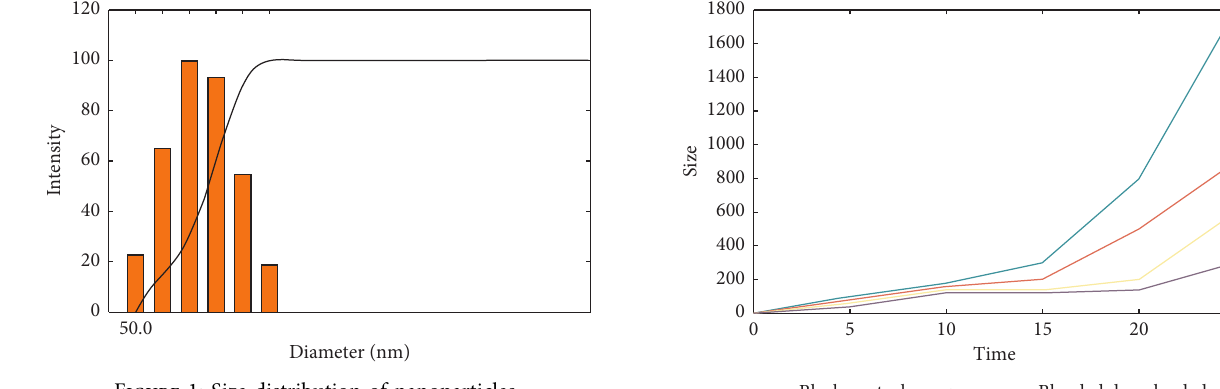
Figure 1: Size distribution of nanoparticles.